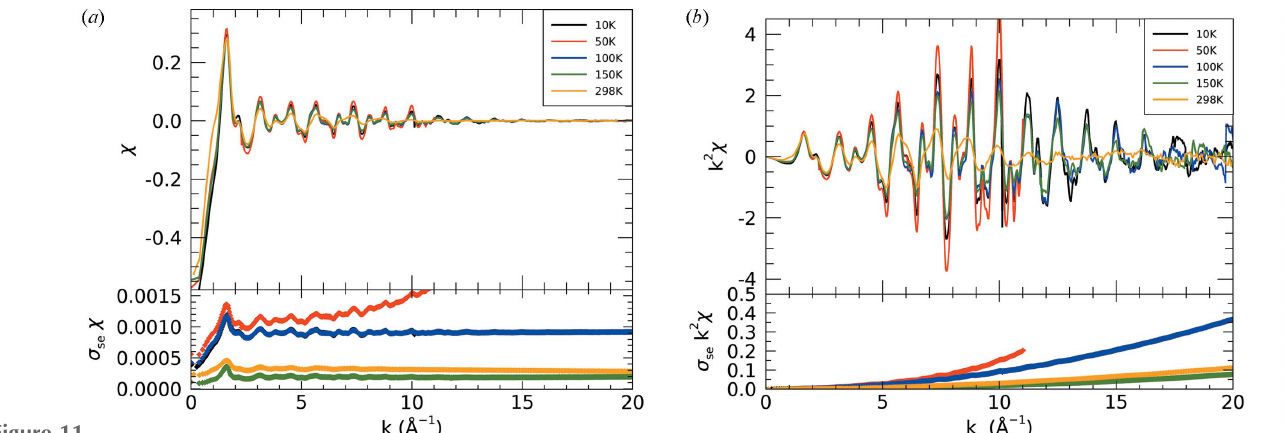
Figure 11 ( a ) Temperature series of (cid:5) ( k ). The 50 K data set was collected with a much narrower k -range, up to k = 11 A˚ (cid:6) 1 . ( b ) Temperature series of k 2 (cid:5) ( k ) showing the structural consistency and yet the change in sharpness with temperature, with resolved peaks to k of 17 A˚ (cid:6) 1 for low